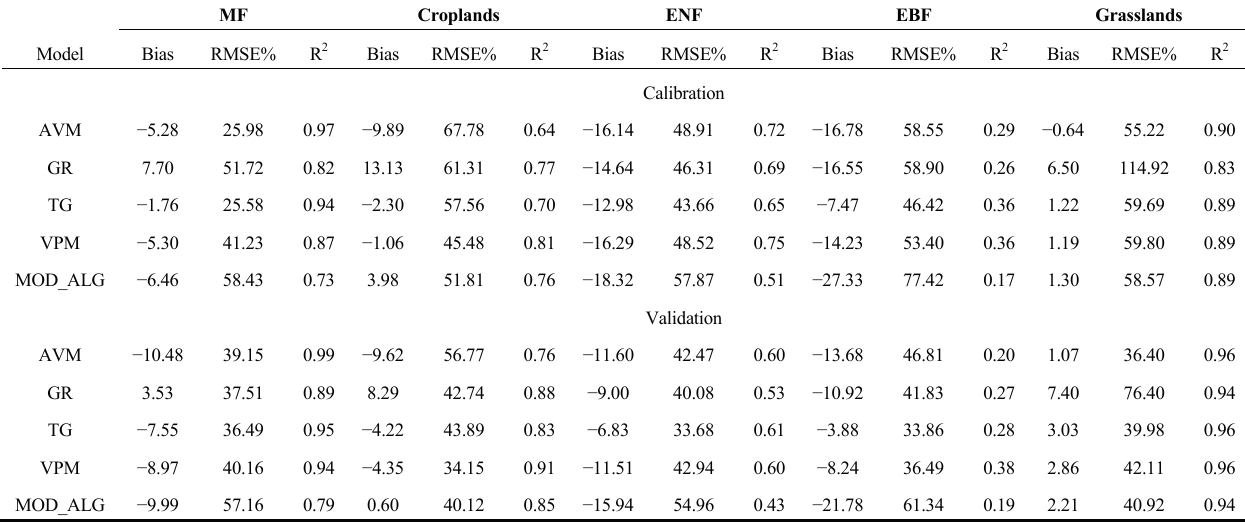
Table 3. Model performances at the periods of calibration and validation . Unit of bias: gC/m 2 /eight-day.